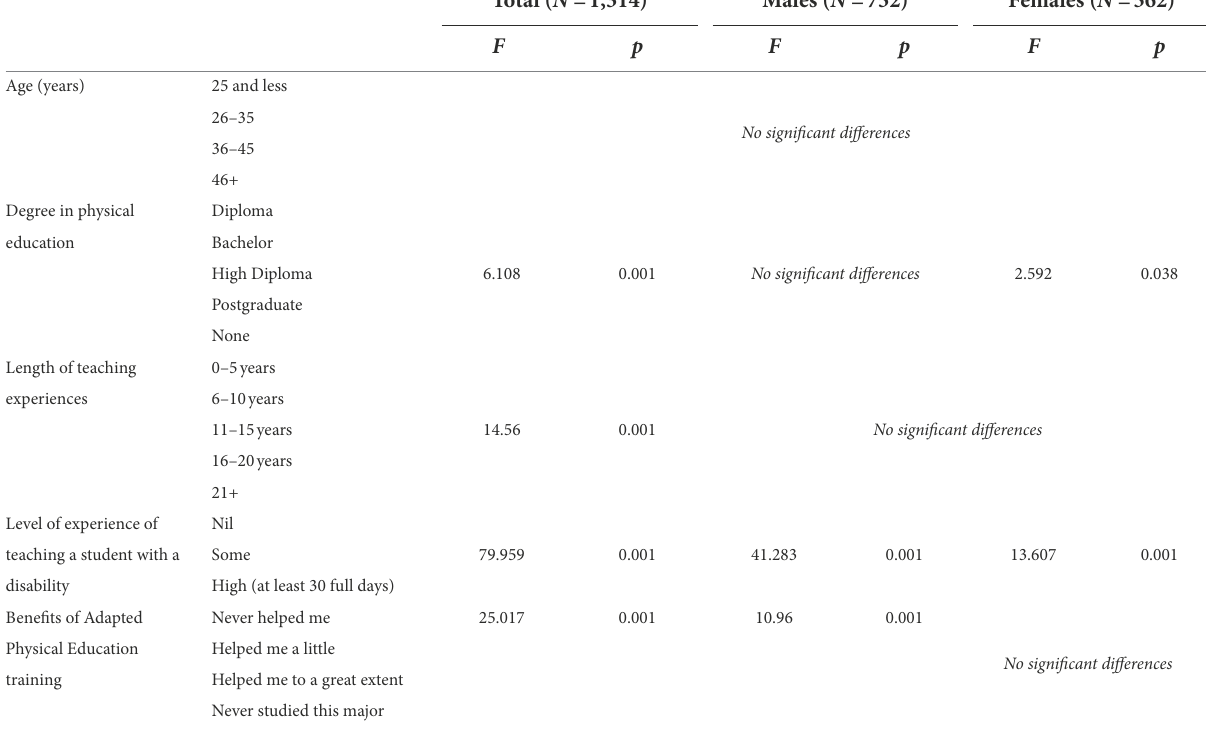
TABLE 2 Differences in PE teachers’ attitudes toward